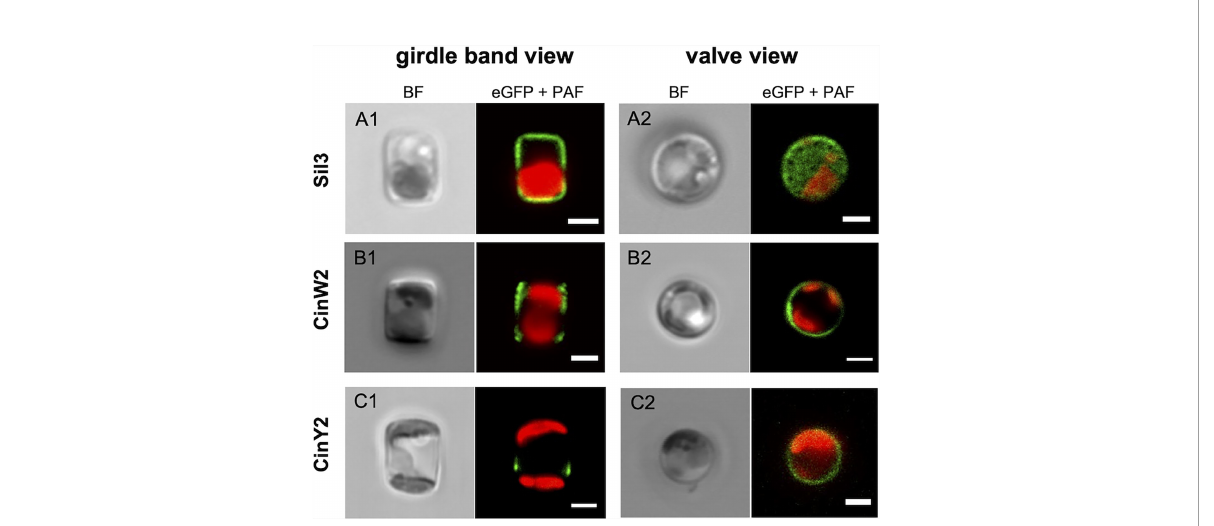
FIGURE 2 In vivo localization of the eGFP-fusion constructs encoding for the proteins Sil3 (A) , CinW2 (B) , and CinY2 (C) . The images show transapical sections of live cells in girdle band view (columns on the left) and transversal sections of live cells in valve view (columns on the right; the valve view of Sil3 is a valve surface view). For each view, the bright fi eld channel (BF) and the merge of green and red channel are displayed, showing the eGFP and plastid auto fl uorescence (PAF) signals, respectively. Scale bars: 2